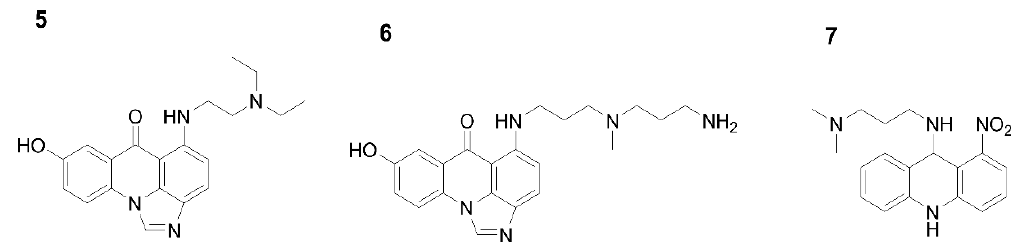
Figure 2. Monomers of the studied unsymmetrical bisacridine structures: 1-alkylamino-8-hydroxy- imidazoacridinone (Symadex ® , C-1311, ( 5 )), 1-alkylaminoimidazoacridinone ( 6 ), and 1-nitro-9-al- kylaminoacridine (Ledakrin, C-283, ( 7 )).